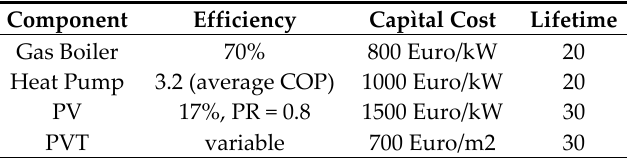
Table 2. Energy hub component parameters.